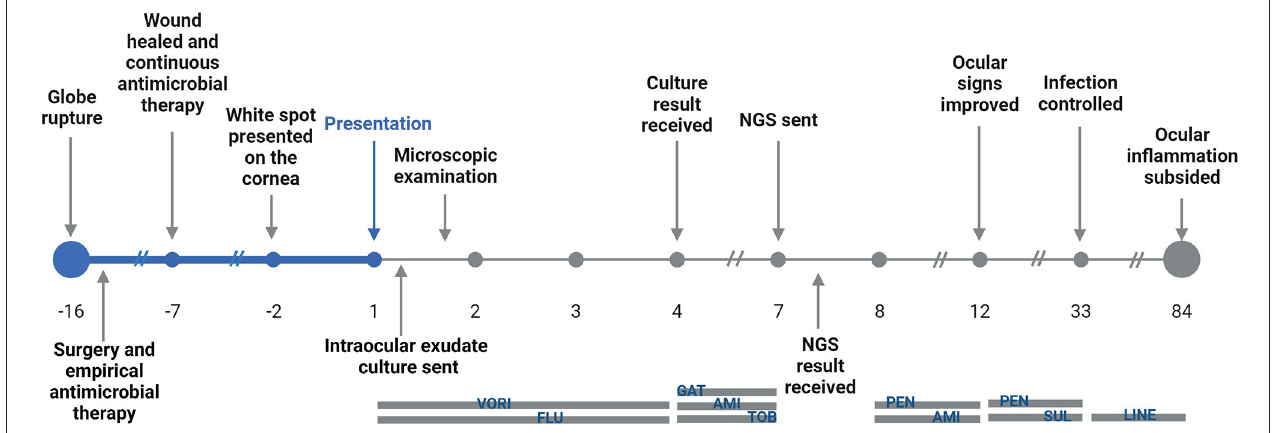
FIGURE 1 | Timeline of the illness progress, pathogen identification, and treatment for the patient. VORI, voriconazole; FLU, fluconazole; GAT, gatifloxacin; AMI, amikacin; TOB, tobramycin; PEN, penicillin; SUL, sulfamethoxazole; LINE,